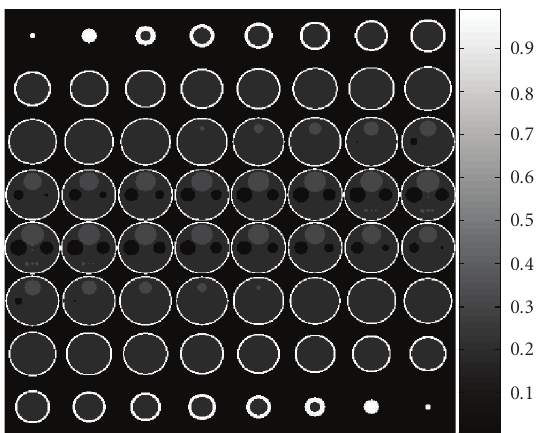
Figure 2: Custom phantom used in simulation.